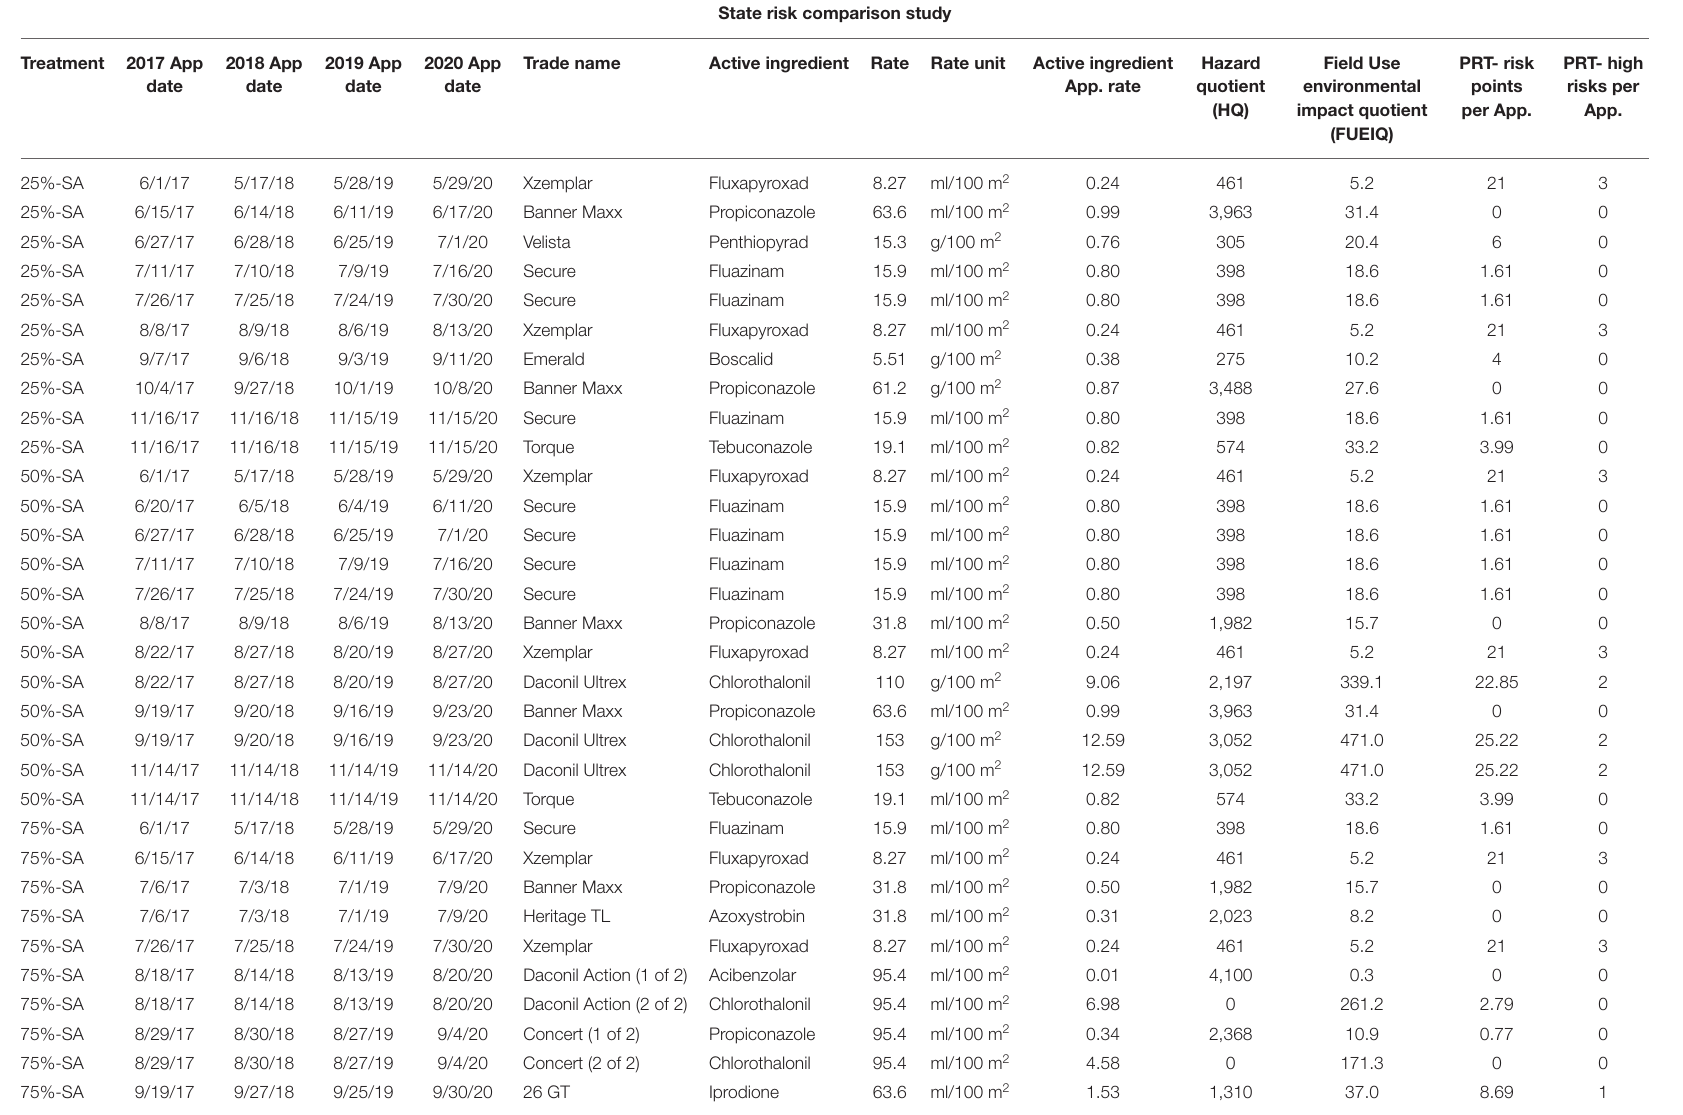
TABLE 3 | State risk comparison study treatment program, date, trade name, active ingredient, rate of application, and pesticide risk as quantified by active ingredient application rate, HQ, hazard quotient; EIQ, Environmental Impact Quotient; PRT, Pesticide Risk Tool for each product applied in the state risk comparison